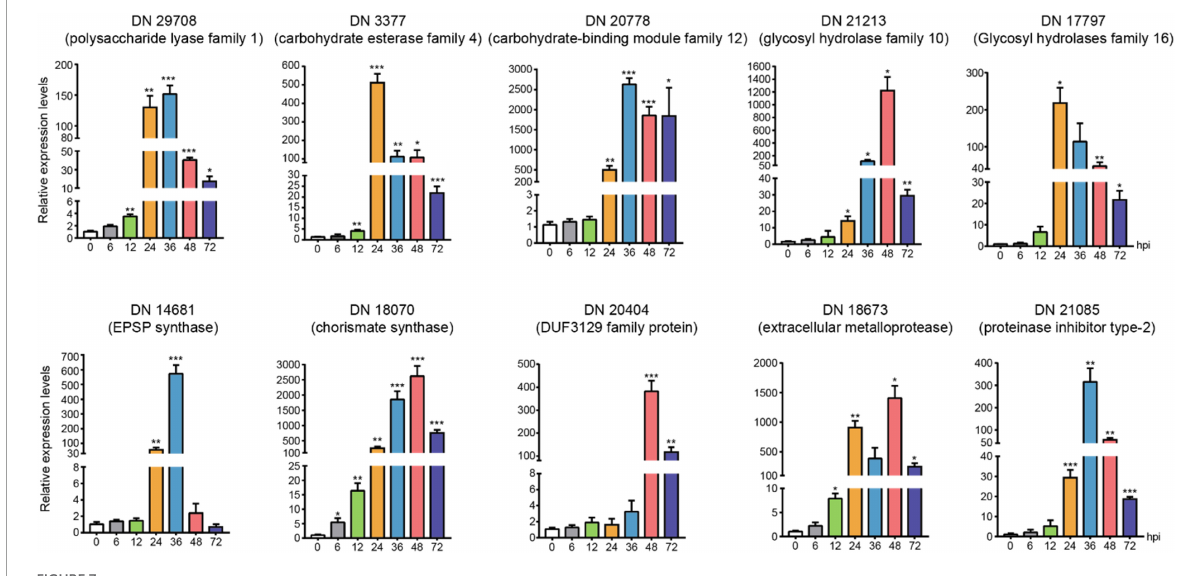
FIGURE7 The expression levels of candidate genes expression patterns of candidate genes associated with toxins, enzymes, and secreted proteins using quantitative real time RT-PCR verification at 0, 6(control), 12, 24, 36, 48, and 72 hours after inoculation. The asterisks showed the statistical significances using the two-tailed t-test (* p < 0.05, ** p < 0.01 *** p <